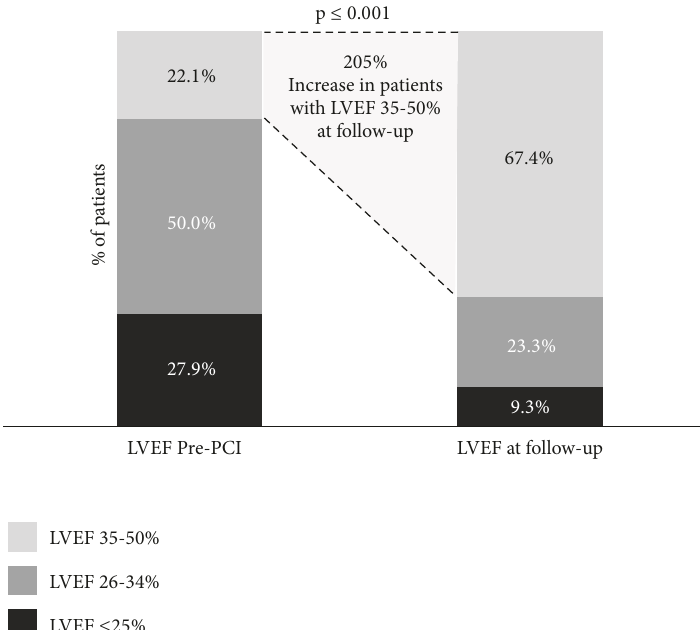
Figure 2: Left ventricular ejection fraction improvement during the follow-up after IMP-protected PCI . The figure shows the comparison of left ventricular ejection fraction impairment between pre-PCI and follow-up assessment. LVEF=left ventricular ejection fraction and PCI=percutaneous coronary intervention.